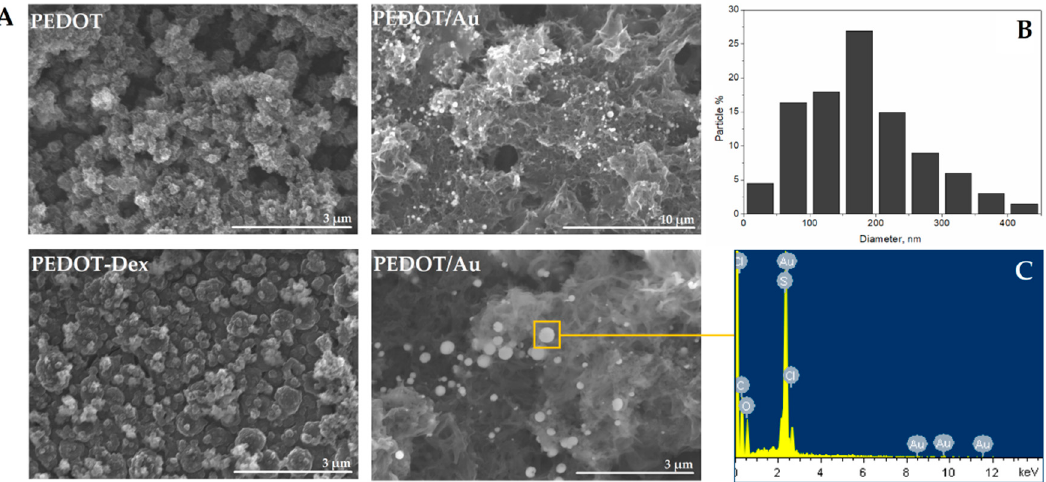
Figure 3. Surface morphology of Dex ‐ functionalized PEDOT and PEDOT composite matrices. ( A ) Scanning electron microscope (SEM) images of PEDOT, PEDOT ‐ Dex and PEDOT/Au matrices. ( B ) Size distribution of gold particles and ( C ) energy ‐ dispersive X ‐ ray (EDS) spectrum of a region of interest depicted in the SEM image.